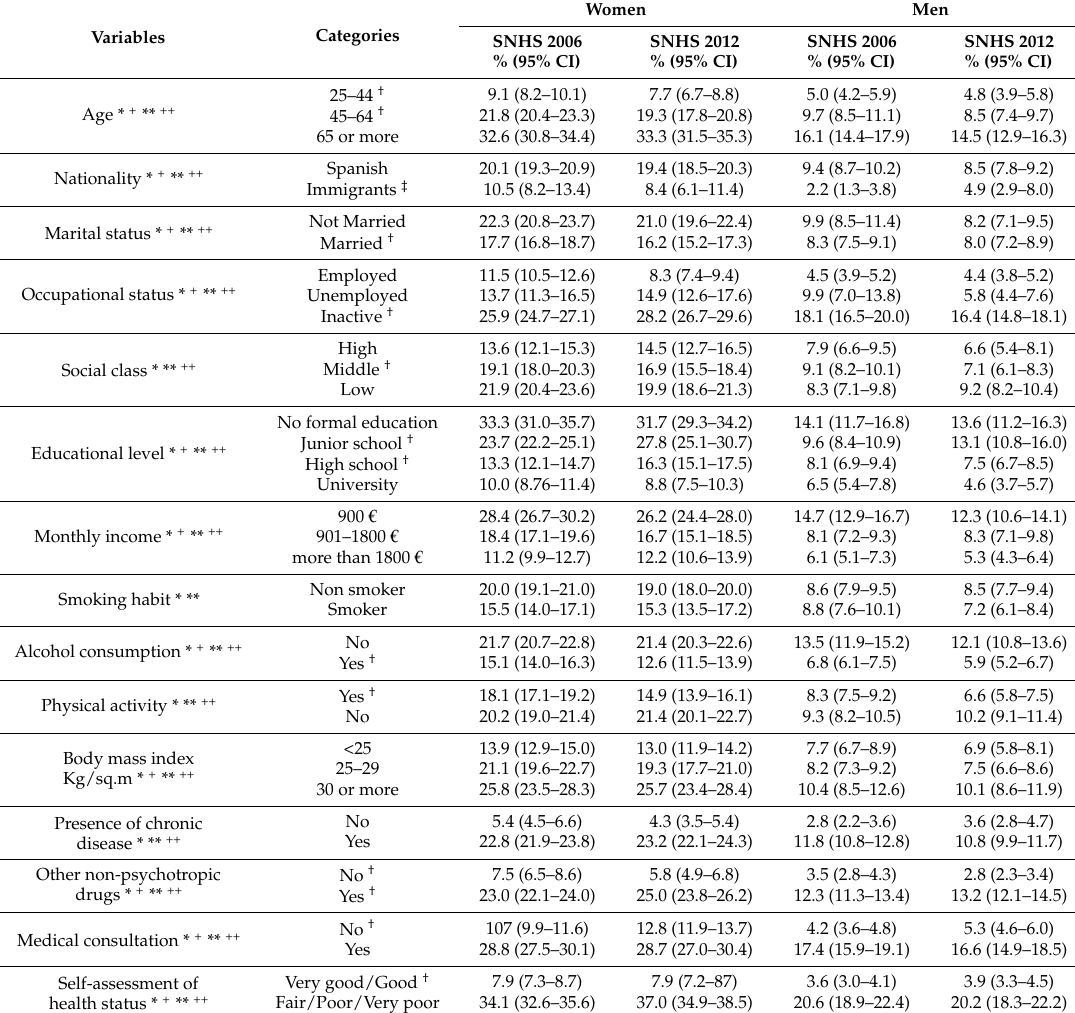
Table 2. Prevalence of psychotropic drug use in adult residents in Spain according to sociodemographic variables, lifestyle; health profile and healthcare resources. Spanish National Health Surveys 2006 and